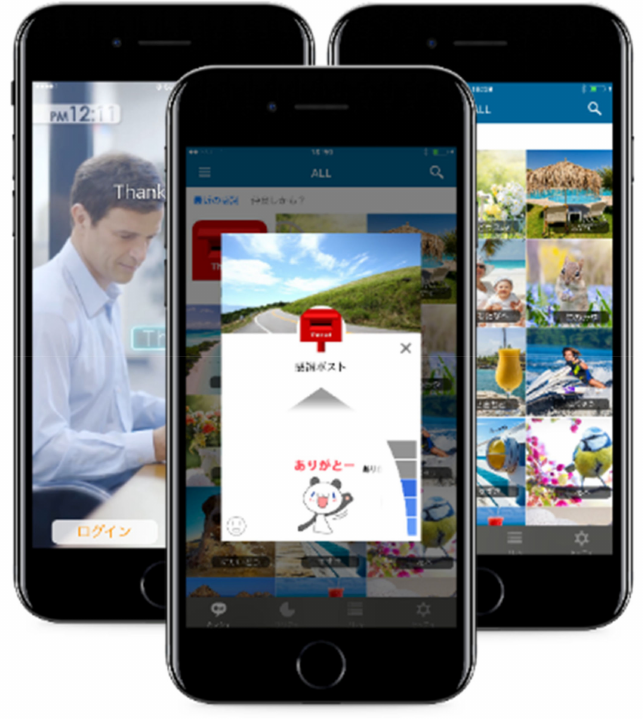
Figure 2. The Thanks App